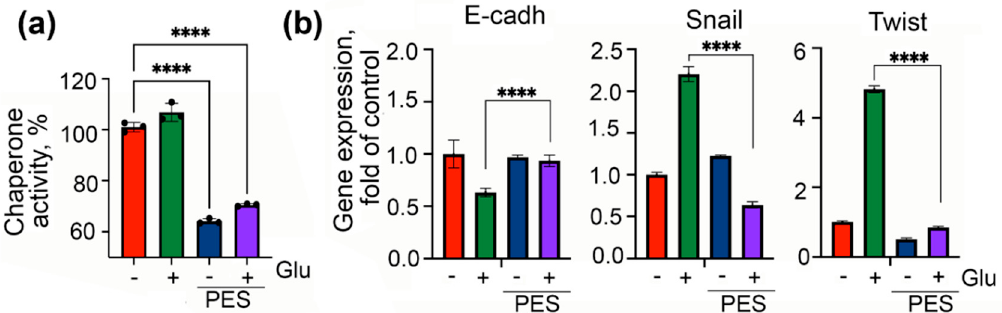
Figure 6. Inhibitor of Hsp70 function, PES, suppresses expression of EMT markers in patient’s HCC-9 cells . ( a ) HCC-9 cells were incubated with 3 μ M PES and 80 mM glucose over 6 days and the chaperone activity of Hsp70 expressed in these cells was measured with aid of Chap-ELISA. **** p < 0.0001. ( b ) Levels of E-cadherin, Snail, and Twist in HCC-9 cells treated with PES and high glucose were measured with aid of qPCR.